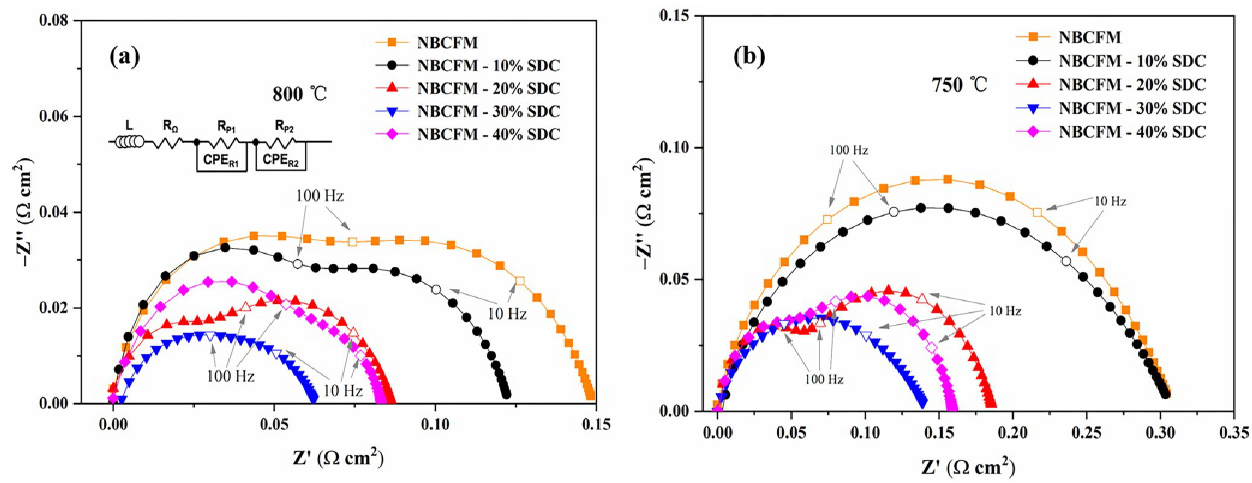
Figure 6. Impedance spectra of the NBCFM and composite electrodes at ( a ) 800 ◦ C and ( b ) 750 ◦ C. Table 2. The fitted results of ASR for NBCFM- x SDC composite cathodes measured at 800 ◦ C in air.